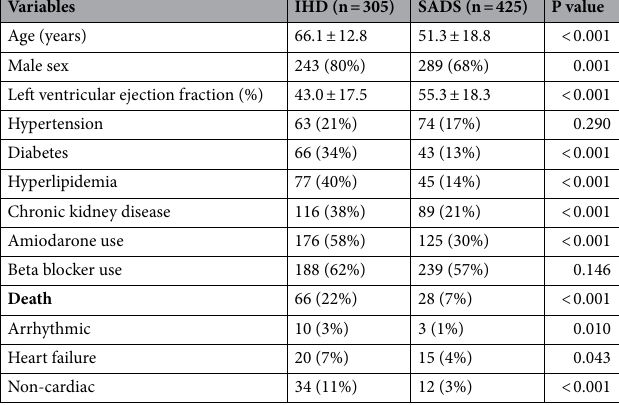
Table 2. Comparisons of clinical characteristics of patients in the presence and absence of ischemic heart disease during follow-up. IHD Ischemic heart disease, SADS Sudden arrhythmia death syndromes.